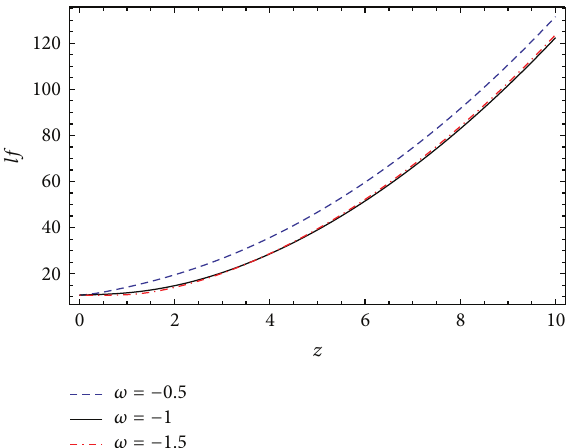
Figure 2: Evolution trajectories of reconstructed 𝑓(𝑇) for quintes- sence model in 𝑙𝑓 − 𝑧 plane with Ω 𝑚0 = 0.315 , 𝐻 0 = 67.3 , and 0 ⩽ 𝑧 ⩽ 10 .